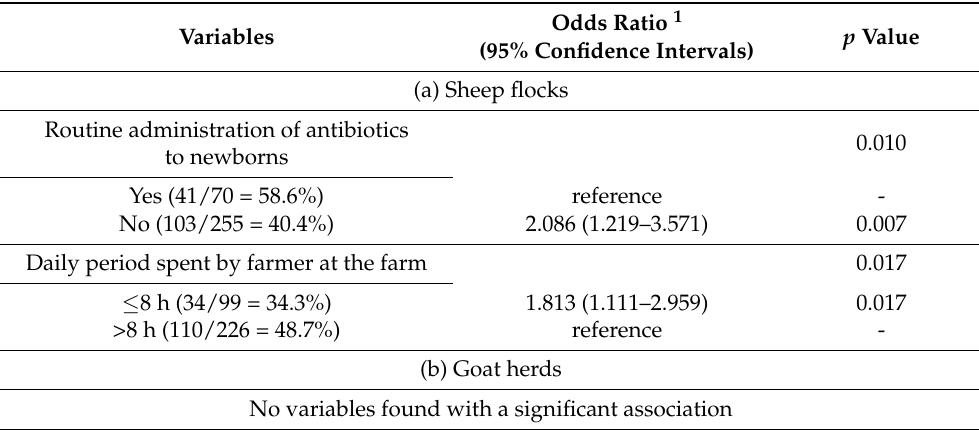
Table A7. Multivariable analysis for variables associated with optional vaccination against pneumo- nia in 444 small ruminant farms in Greece.